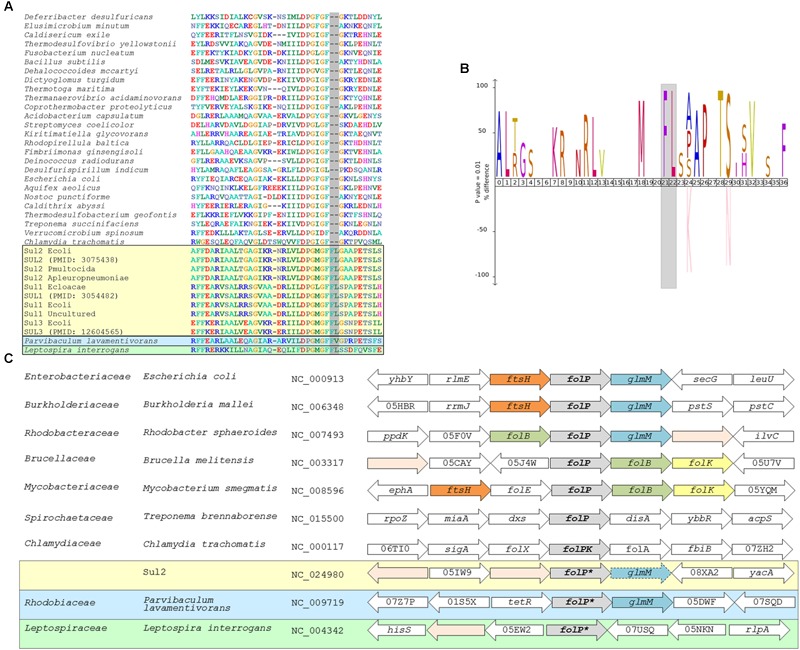
(A) Segment of the multiple sequence alignment including any sul genes with at most 90% similarity to reported sul genes and a representative chromosomal folP gene for all bacterial phyla with complete genomes available in NCBI RefSeq. (B) IceLOGO highlighting the difference in amino acid frequency at each position of the region of the folP protein sequence containing the identified insertion between the multiple sequence alignment of sul gene products and the chromosomally encoded FolP proteins. The upper part of the iceLOGO plot shows residues overrepresented in the sul-encoded FolP proteins; the bottom part shows residues overrepresented in chromosomally encoded FolP proteins for all bacterial phyla with complete genomes available. Only differences with significant z-score under a confidence interval of 0.01 are shown. (C) Schematic representation of the genetic environment of sul2 genes, similar arrangements in chromosomally encoded folP genes of the Gammaproteobacteria, Betaproteobacteria, and Alphaproteobacteria, and arrangements in other major phyla. Arrow boxes indicate coding regions. When available, gene names or NOG identifiers are provided. Boxes for folP genes containing the two-amino acid insertion are designated as folP∗.